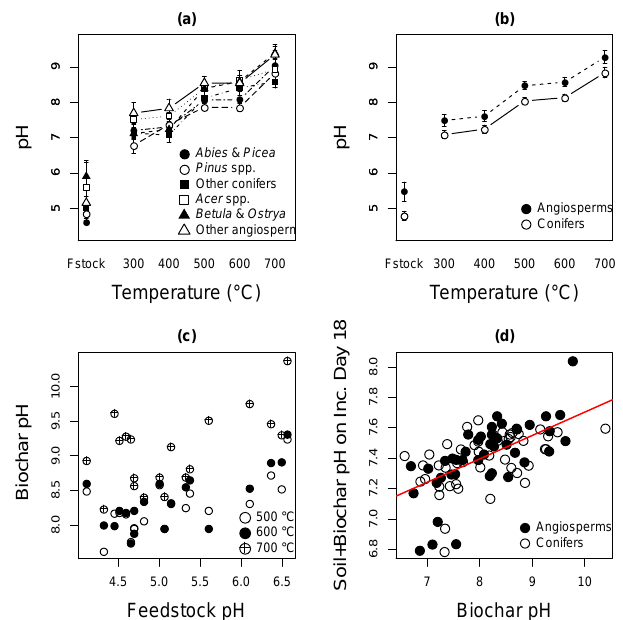
Figure 1. Biochar and feedstock pH as a function of temperature by taxonomic group ( a ) and grouped as conifers vs. angiosperms ( b ); biochar pH as a function of feedstock pH ( c ) and liming potential of biochar across five pyrolysis temperatures grouped by feedstock type; regression line drawn relating measured pH (pH of soil+biochar on incubation Day 18 = 0.15397*Biochar pH + 6.16463) ( d ). All analyses are from 19 temperate tree species (conifer species ( n = 9) and angiosperm species ( n =